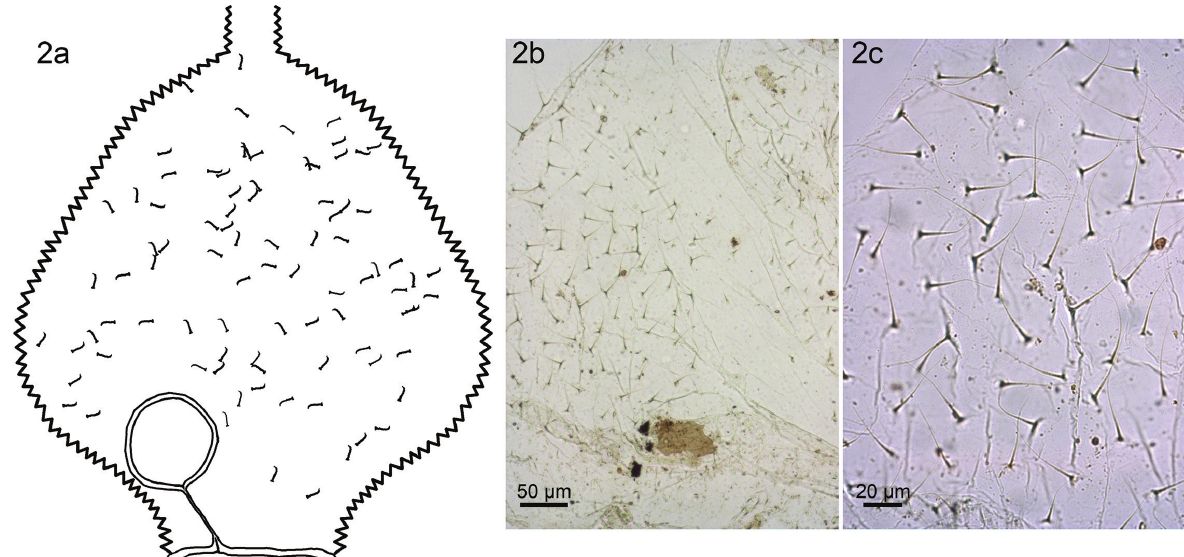
Figure 2. Armitermes spininotus . (a) Schematic drawing of P1 showing arrangement of ornamentation. (b, c) Photomicrographs: (b) General view; (c) Detail of ornamentation of thin